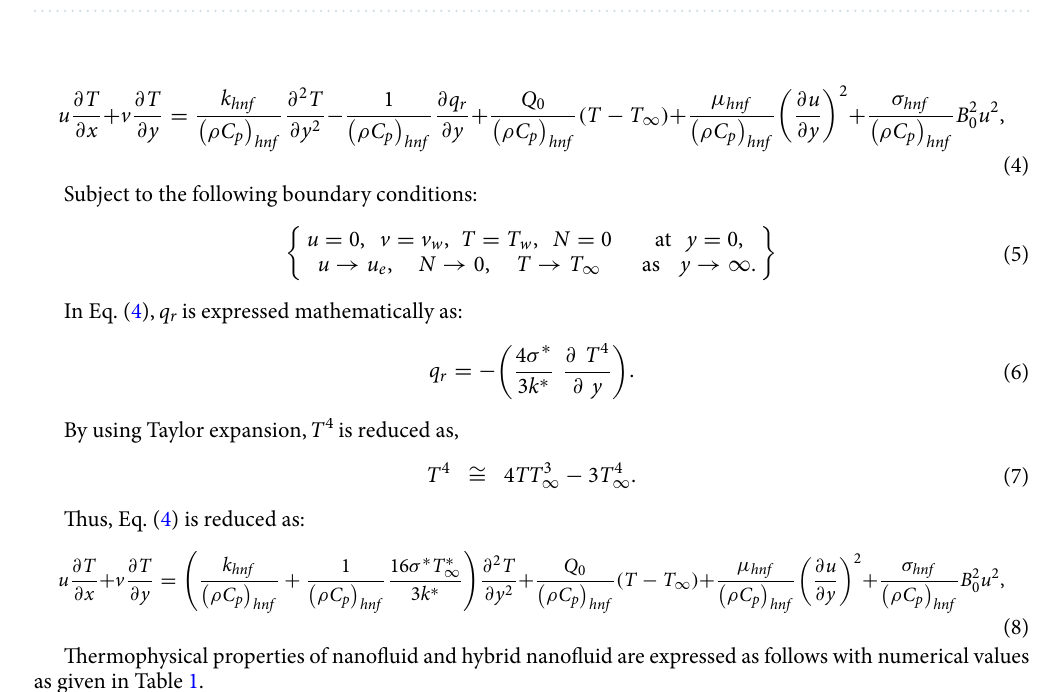
Table 1. Numerical values of thermophysical properties for water and nanoparticles 59